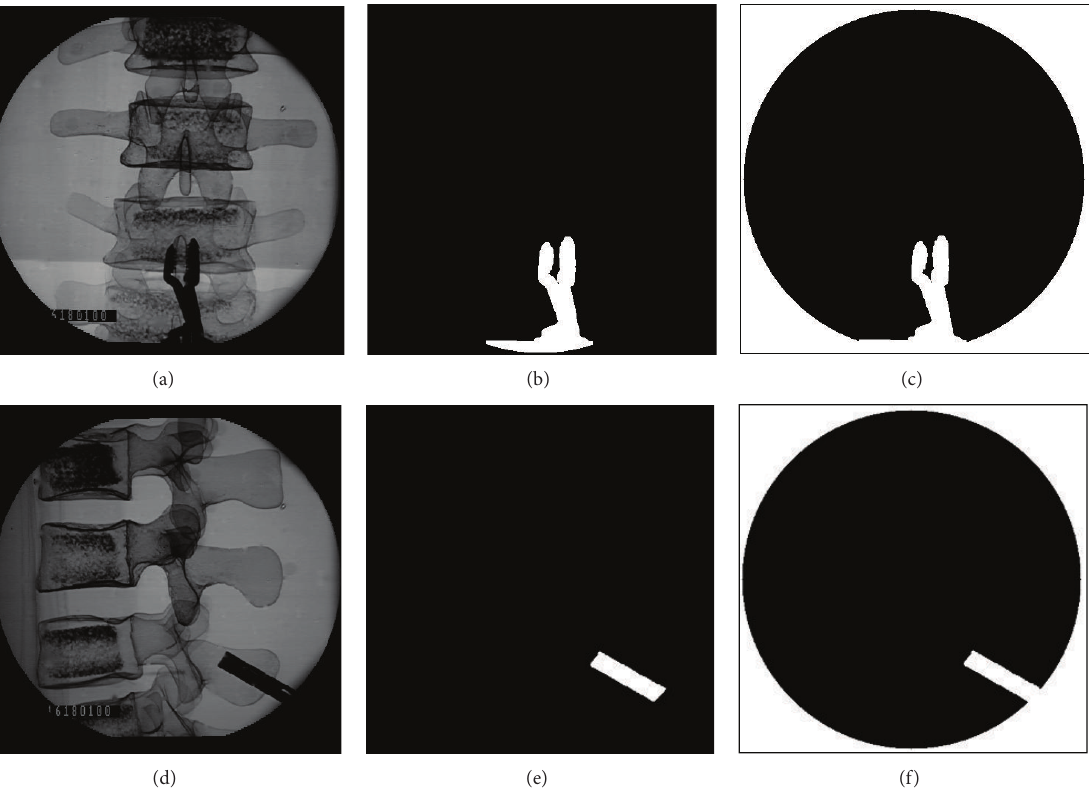
Figure 7: (a) Original AP-view image. (b) Segmentation of the instrument. (c) The mask for AP-view DRR image. (d) Original LA-view image. (e) Segmentation of the instrument. (f) The mask for LA-view DRR image.